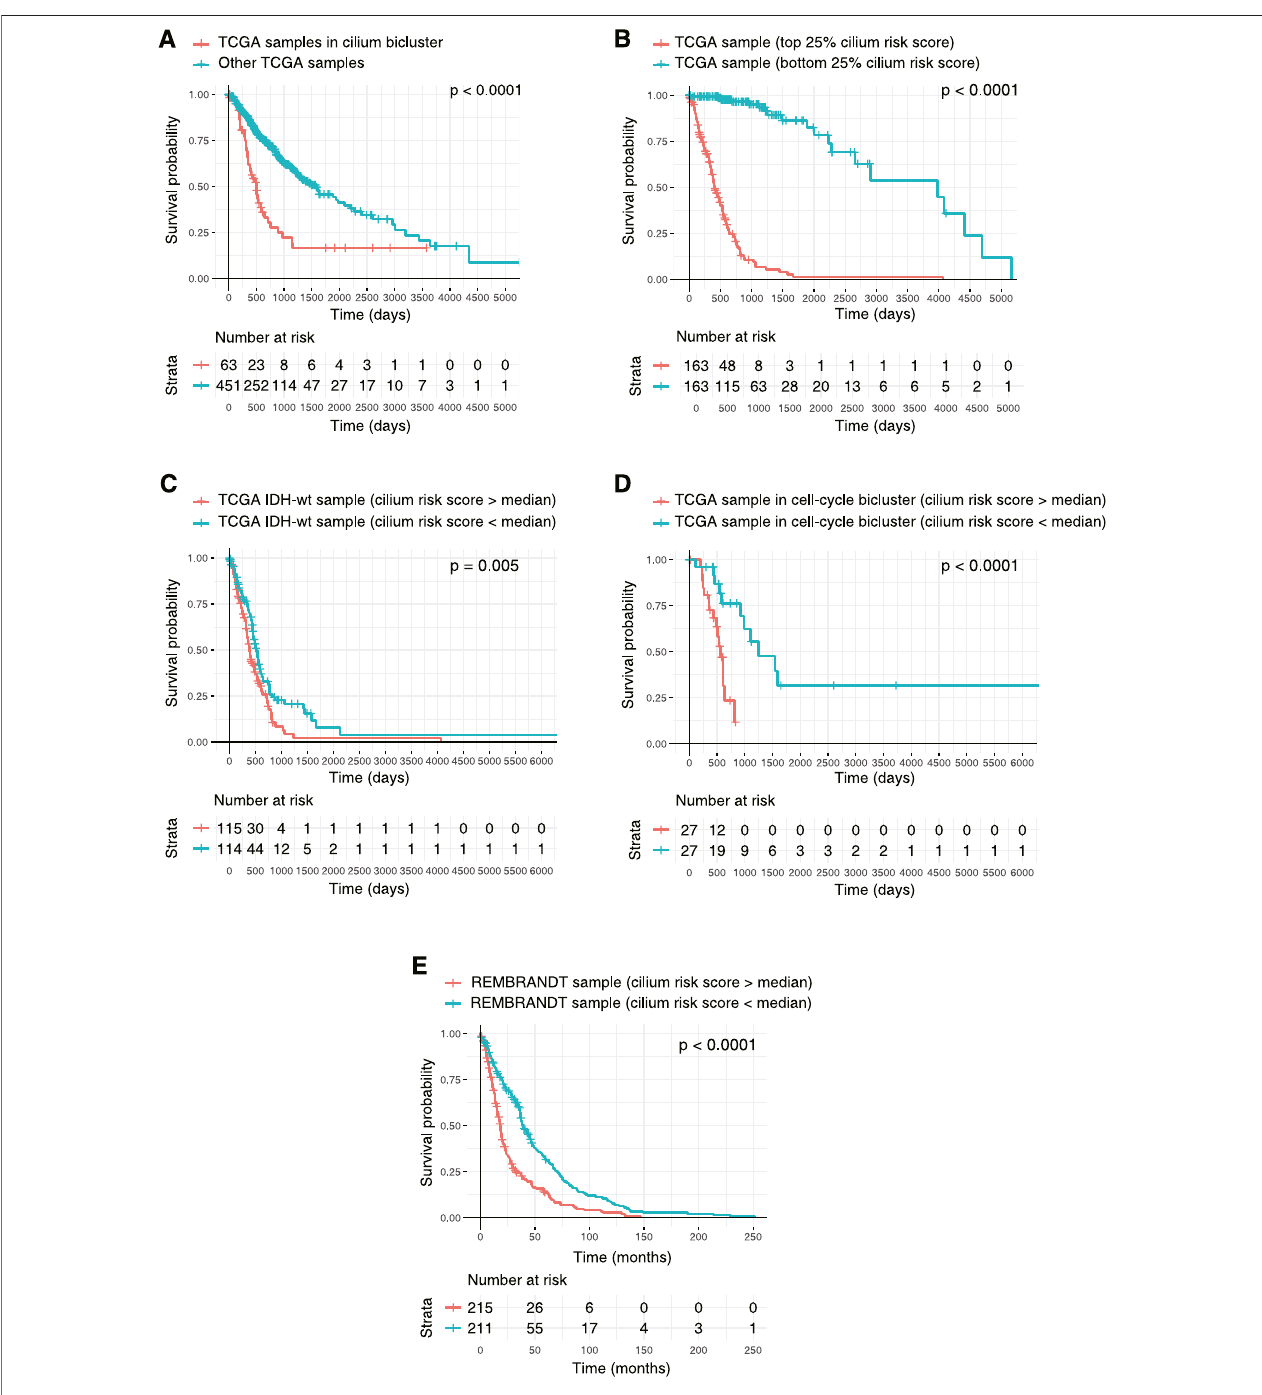
FIGURE8| Kaplan-MeiersurvivalanalysisofTCGAtumorsbasedontheirciliumexpression. (A) PatientswithTCGAtumorsintheciliumbiclusterhadworseoverall survival (OS) compared to other patients. (B) Patients with tumors in the top 25% cilium risk score had poorer OS compared to patients with tumors in the bottom 25% cilium riskscore. (C) Patients with IDH1/2 wild-type gliomas with cilium riskscores belowthe population ’ smedian had poorer OScompared tothosewith scoresabove the median. (D) Cilium risk score strati fi ed patient OS in biclusters associated with poor prognosis, including a bicluster enriched in cell cycle. (E) Cilium risk score was reproducibly predictive of OS for patients in the independent REMBRANDT cohort.